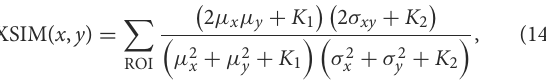
challenge 2.0 (QSM Challenge 2.0 Organization Committee et